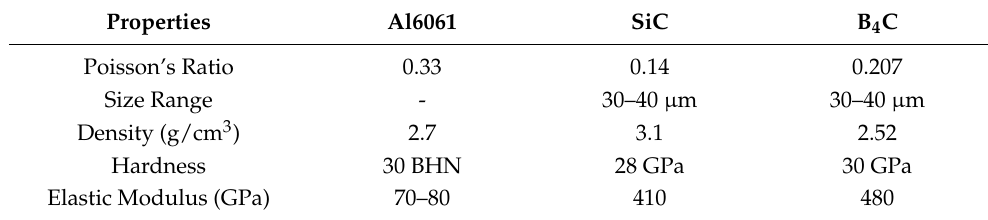
Table 2. Properties of Al6061 alloy, SiC, and B 4 C reinforcements